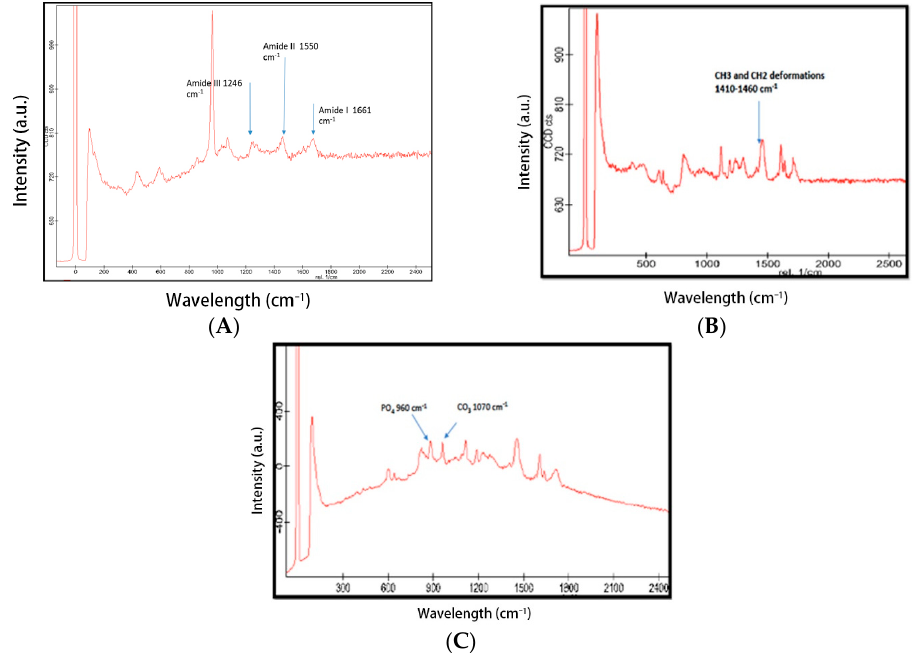
Figure 6. Raman spectra ( A ) The peaks at 1246 cm − 1 , 1550 cm − 1 , and 1661 cm − 1 are associated with representing dentin at the interface. ( B ) Control Adhesive. The peaks between 1410 and 1460 cm − 1 are due to the “–CH3 and –CH2” deformations within the adhesive. ( C ) HA-modified adhesive. The inclusion of HA nanoparticles in the adhesive is evidenced by the spectrum at 960 cm − 1 for phosphate and 1070 cm − 1 for